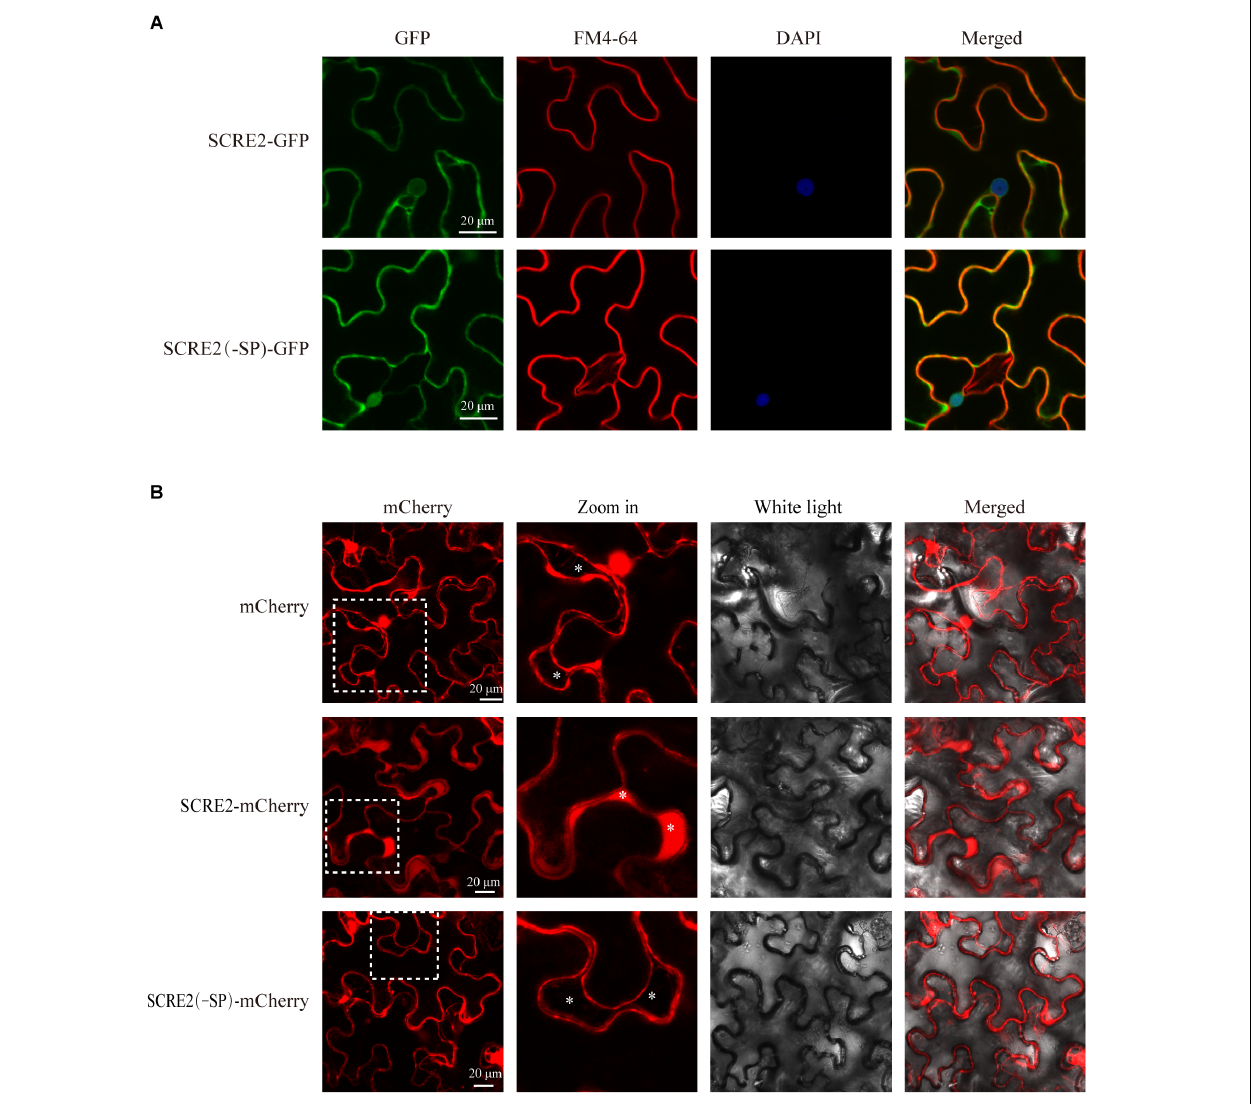
FIGURE 2 | SCRE2 is localized in multiple subcellular compartments and periplasmic spaces in plants. (A) SCRE2-GFP was localized to the nuclei, cytoplasm, and plasma membrane of N. benthamiana cells. Green fluorescence was observed in the N. benthamiana cells transiently expressing SCRE2-GFP and SCRE2(-SP)-GFP via laser scanning confocal microscopy. GFP panels: green fluorescence; FM4-64 panels: red fluorescence after staining with the membrane-binding lipophilic dye FM4-64; DAPI panels: blue fluorescence in the nuclei after staining with DAPI; merged panels: overlay images of the three fluorescence signals. The yellow color in overlay images indicates overlap of green and red fluorescence, while the cyan color in overlay images indicates overlap of green and blue fluorescence. (B) SCRE2-mCherry was localized in the periplasmic spaces of N. benthamiana cells after plasmolysis. Red fluorescence was observed in the plasmolyzed N. benthamiana cells transiently expressing mCherry, SCRE2-mCherry, and SCRE2(-SP)-mCherry via laser scanning confocal microscopy. SCRE2(-SP): SCRE2 without the signal peptide; mCherry panels: red fluorescence; Zoom in panels: enlarged images from broken square areas in mCherry panels. Astericks indicate the periplasmic spaces after N. benthamiana cells were plasmolyzed. Scale bar, 20 µ